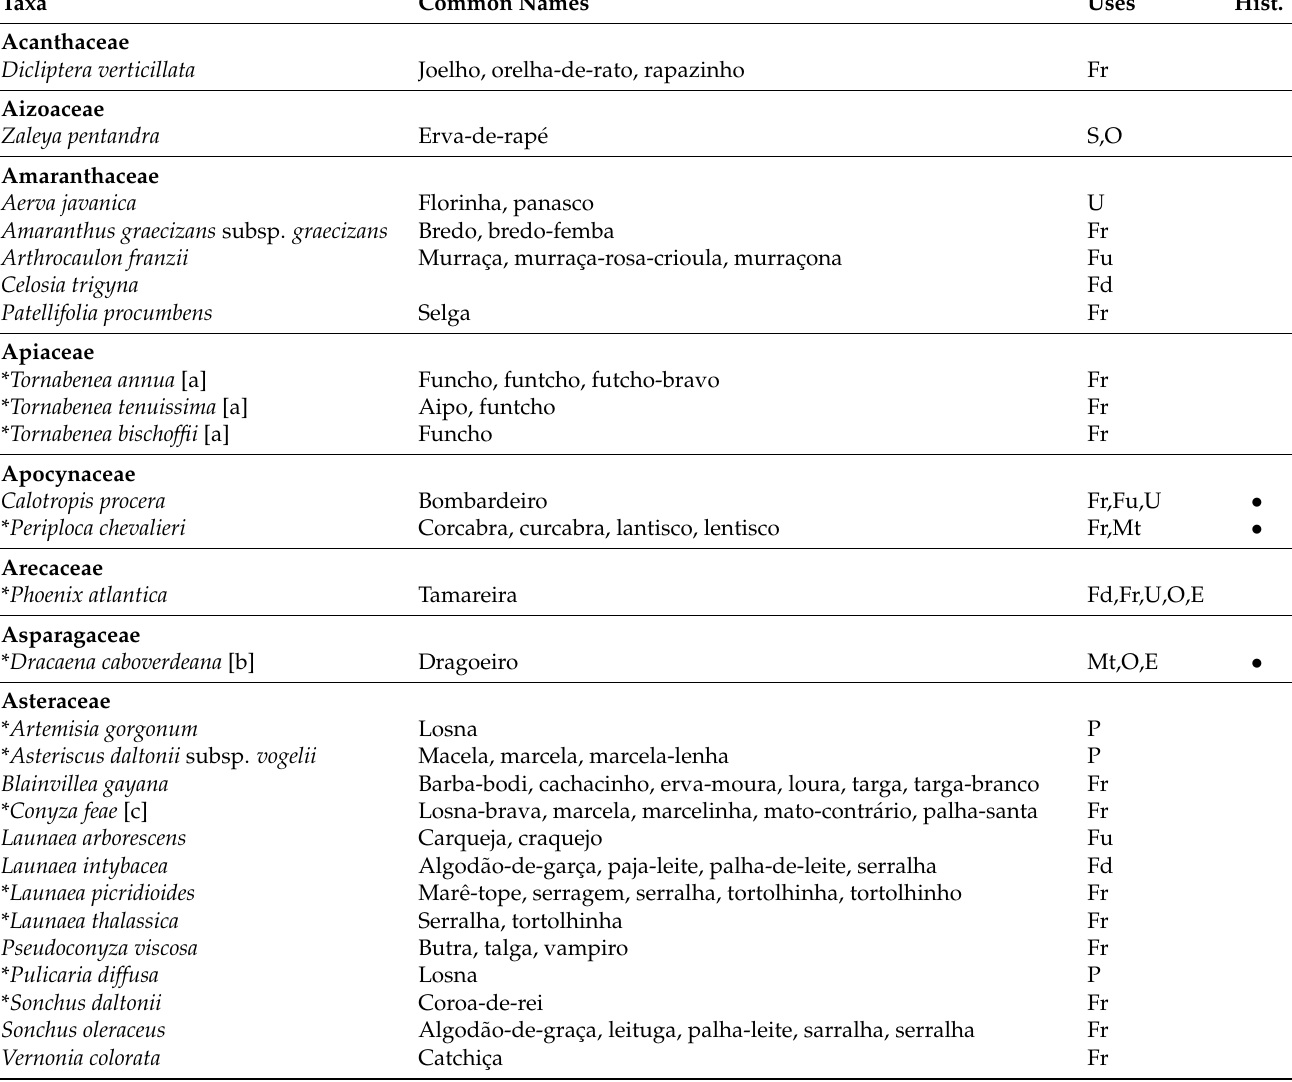
Table 1. Native useful taxa occurring in Cabo Verde, including information on family, common names (mostly in creole), main uses (Fd, food; Fr, forage; Ml, melliferous; P, poison; S, social uses; Fu, fuelwood; T, timber; U, utilitarian uses; Mt, materials; O, ornamental; E, environmental use; for details, see Materials and Methods), and historical use (Hist.). Taxonomic authorities according to Plants of the World Online